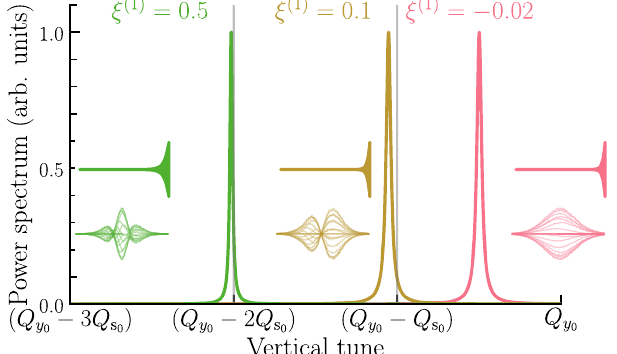
head-tail instabilities for three head-tail modes l ¼ 0 (right curves), l ¼ − 1 (middle curves), and l ¼ − 2 (left curves). Those are the instabilities when both the longitudinal and the transverse detuning are zero.